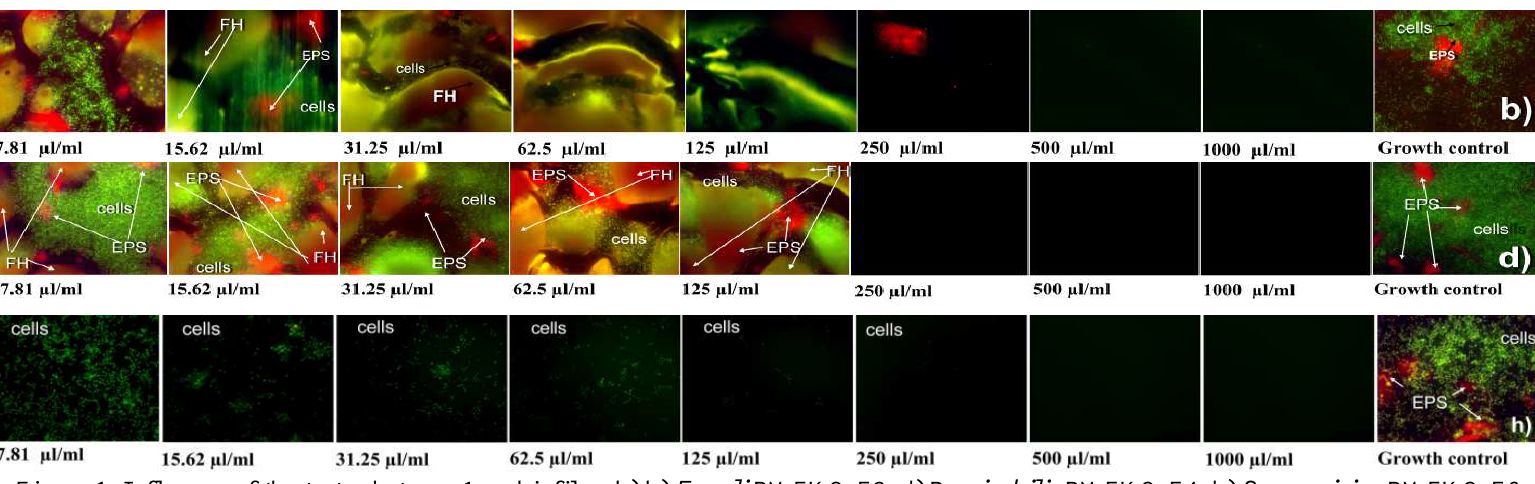
Figure 1. Influence of the test substance 1 on biofilms b) b) E. coli PMFKG-F2, d) P . mirabilis PMFKG-F4, h) S. cerevisiae PMFKG-F6.